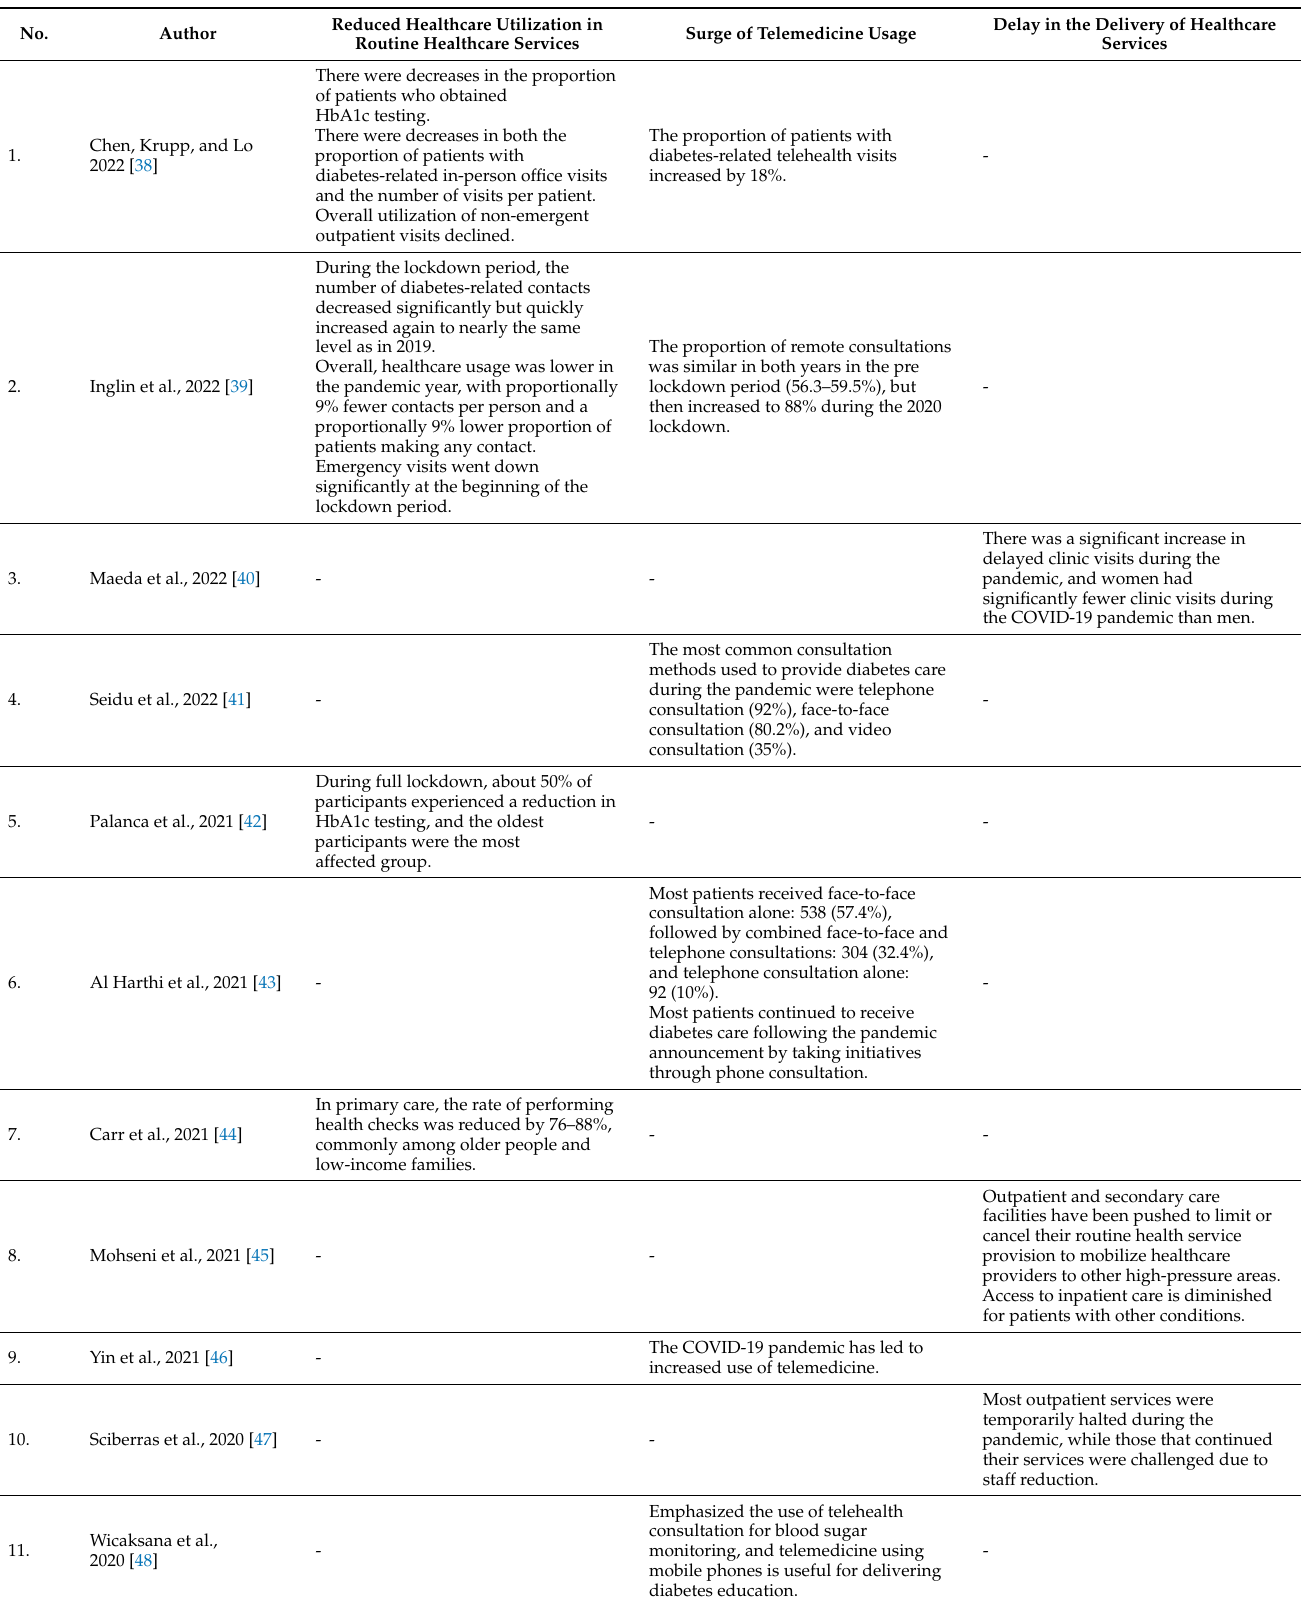
Table 3. Summary of study findings based on the derived